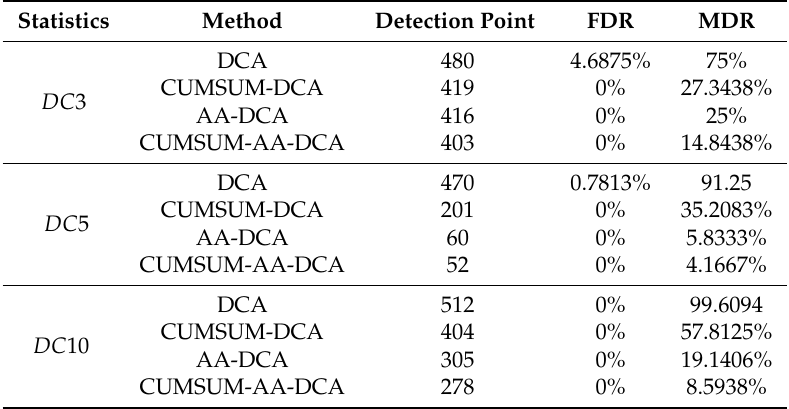
Table 2. Detection results of the Shewhart chart for